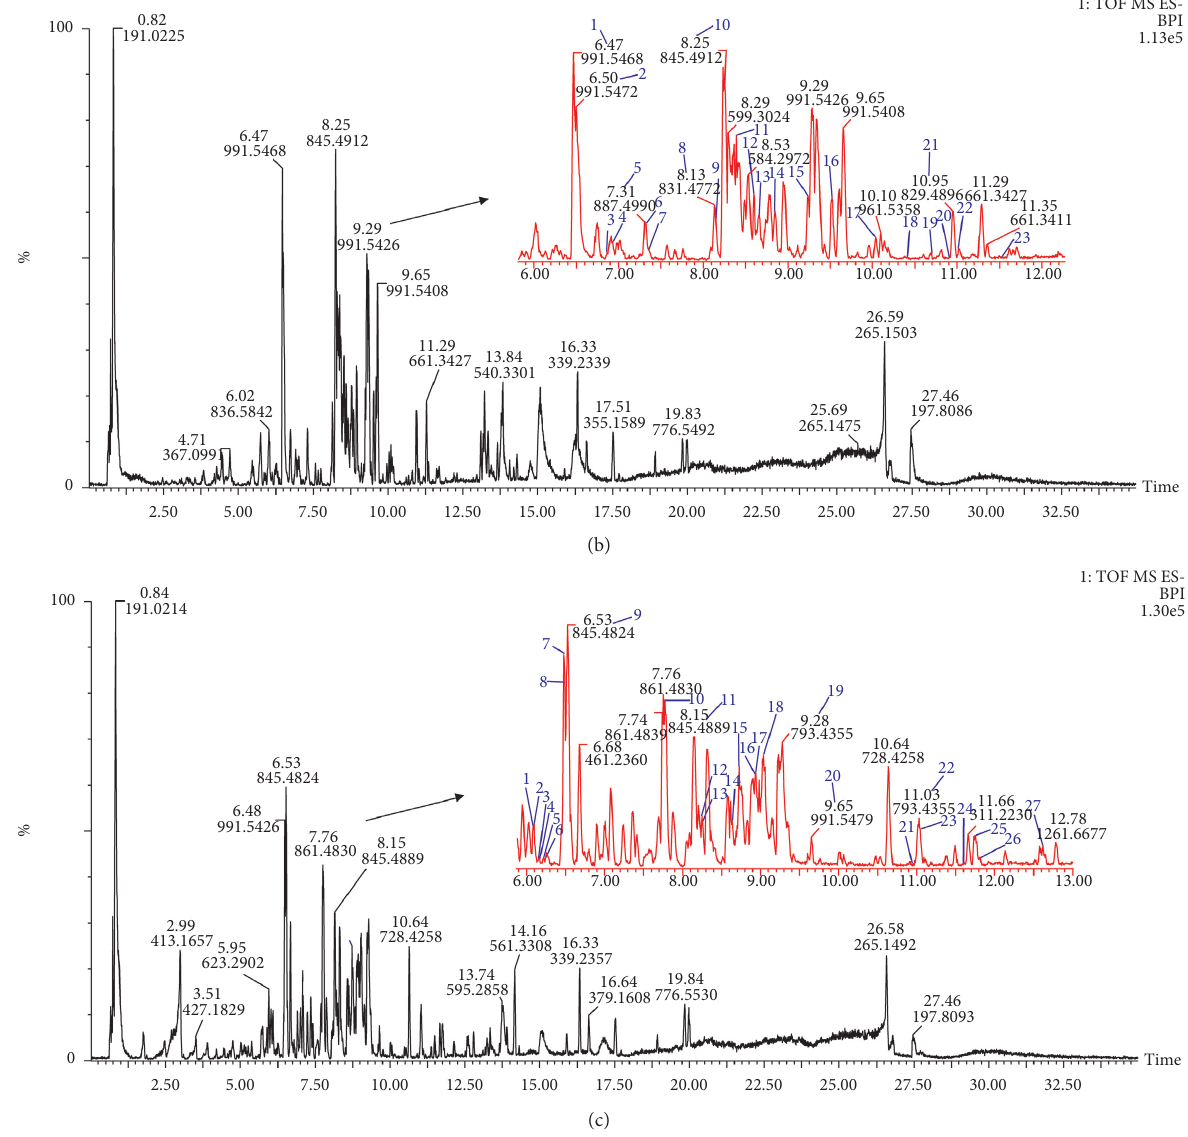
Figure 3: Chromatogram BPI diagram of PG, PJ, and PQ under negative ions (a) PG, (b) PQ, and (c)